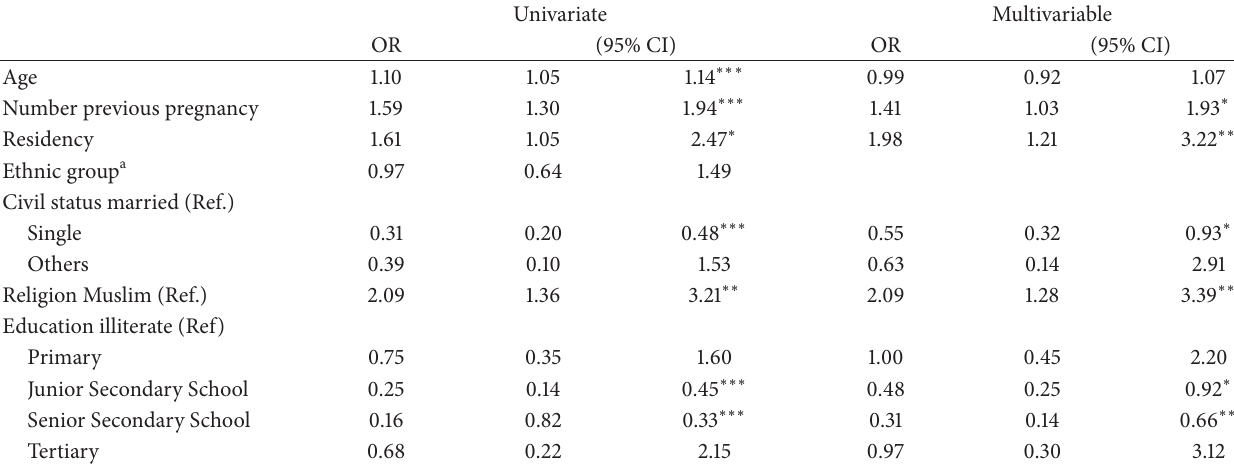
Table 3: Results of univariate and multivariate logistic regression analyses for the outcome variable